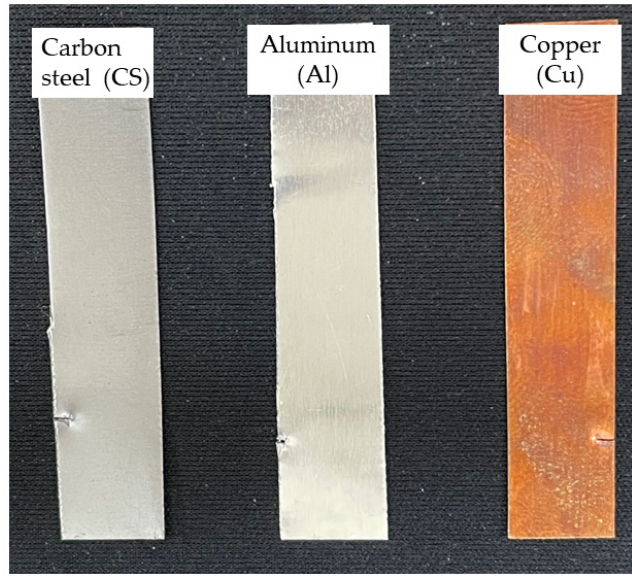
Figure 12. Metal strips after 12 weeks of corrosion testing.